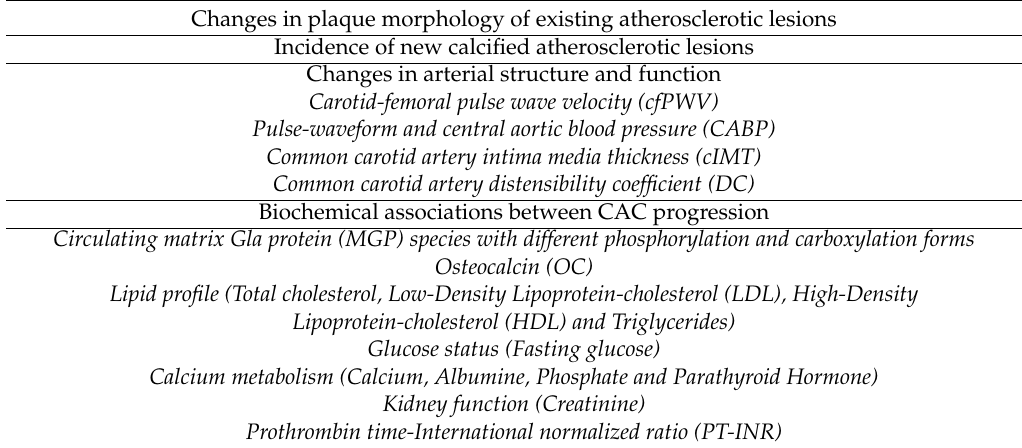
Table 1. Secondary